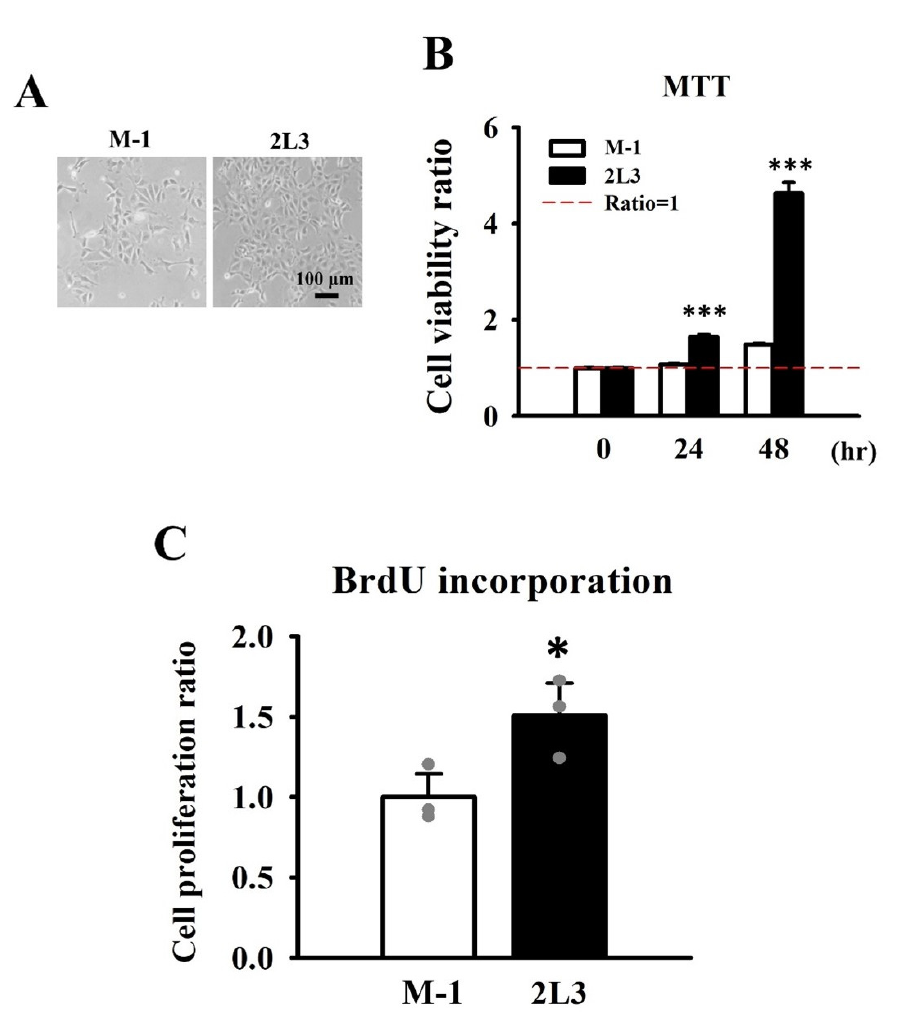
Figure 2. Comparison of cell viability and proliferation between M-1 wild type and 2L3 cells. ( A ) Representative images of M-1 and 2L3 cells cultured for 48 h. Scale bar: 100 µm. ( B ) MTT assay